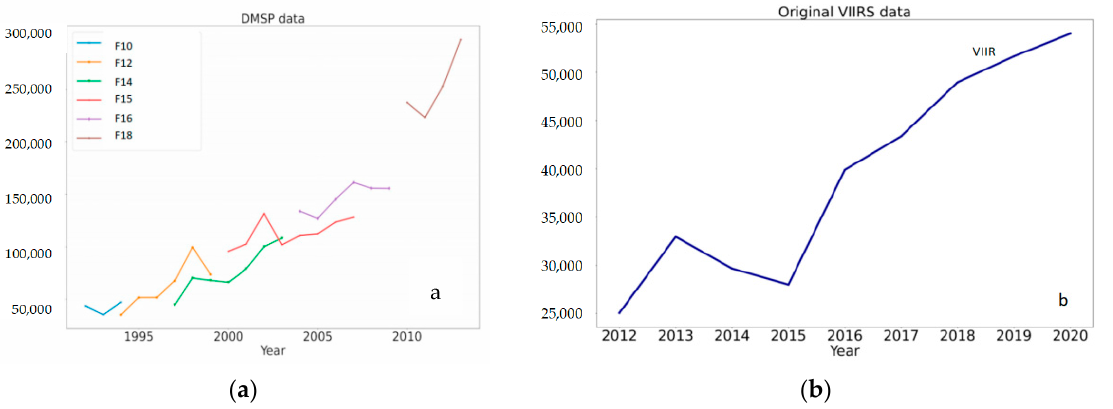
Figure 2. The TDN range of the remotely sensed NTL datasets used. ( a ) the original DMSP/OLS NTL datasets (F10–18 indicates the sensor number) and ( b ) original NPP/VIIRS datasets.